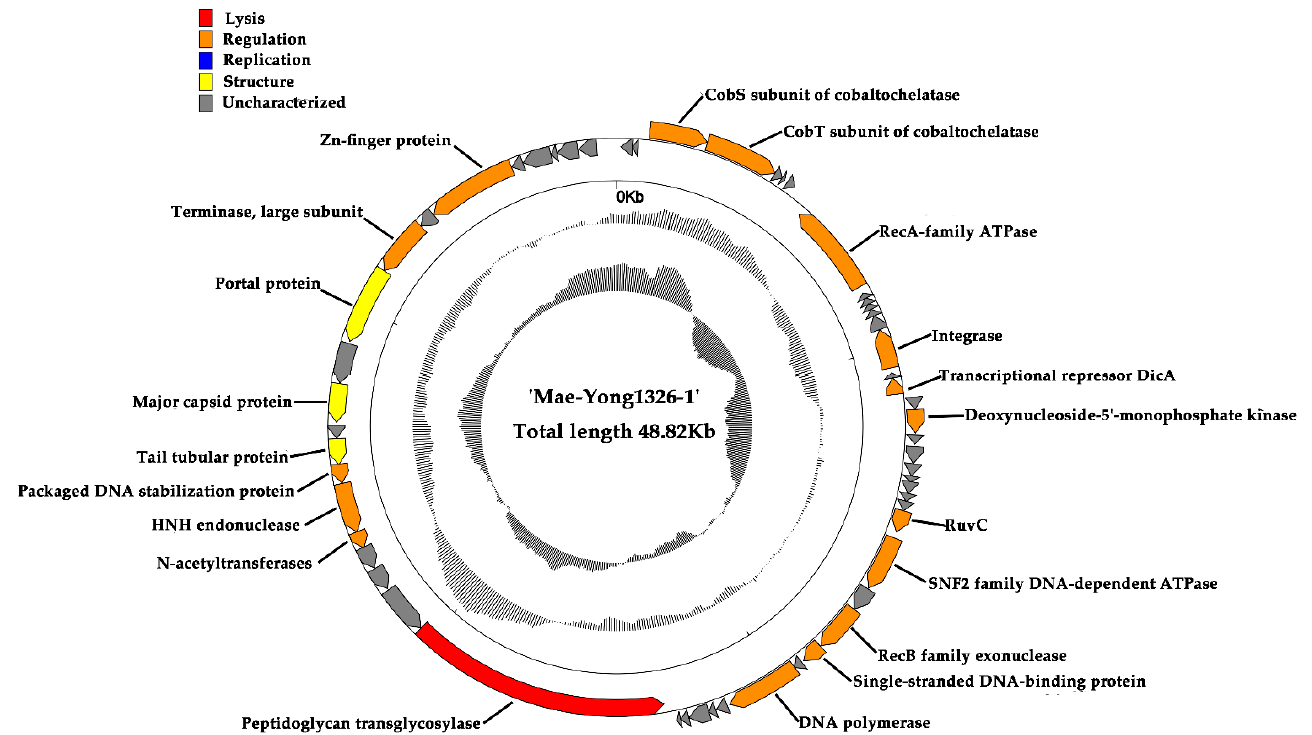
Figure 4. Genome map of Microcystis cyanophage Mae-Yong1326-1. The outermost circle represents 57 ORFs encoded in the genome, with different colors representing different functions (clockwise arrow indicates the forward reading frame; counterclockwise arrow indicates the reverse reading frame); the dark circles in the middle represent the GC content (Black indicates greater than the average GC content compared with the whole genome, and gray indicates the opposite); the innermost circle represents the GC skew (G − C/G + C: Outwards indicates > 0, and inwards indicates < 0).